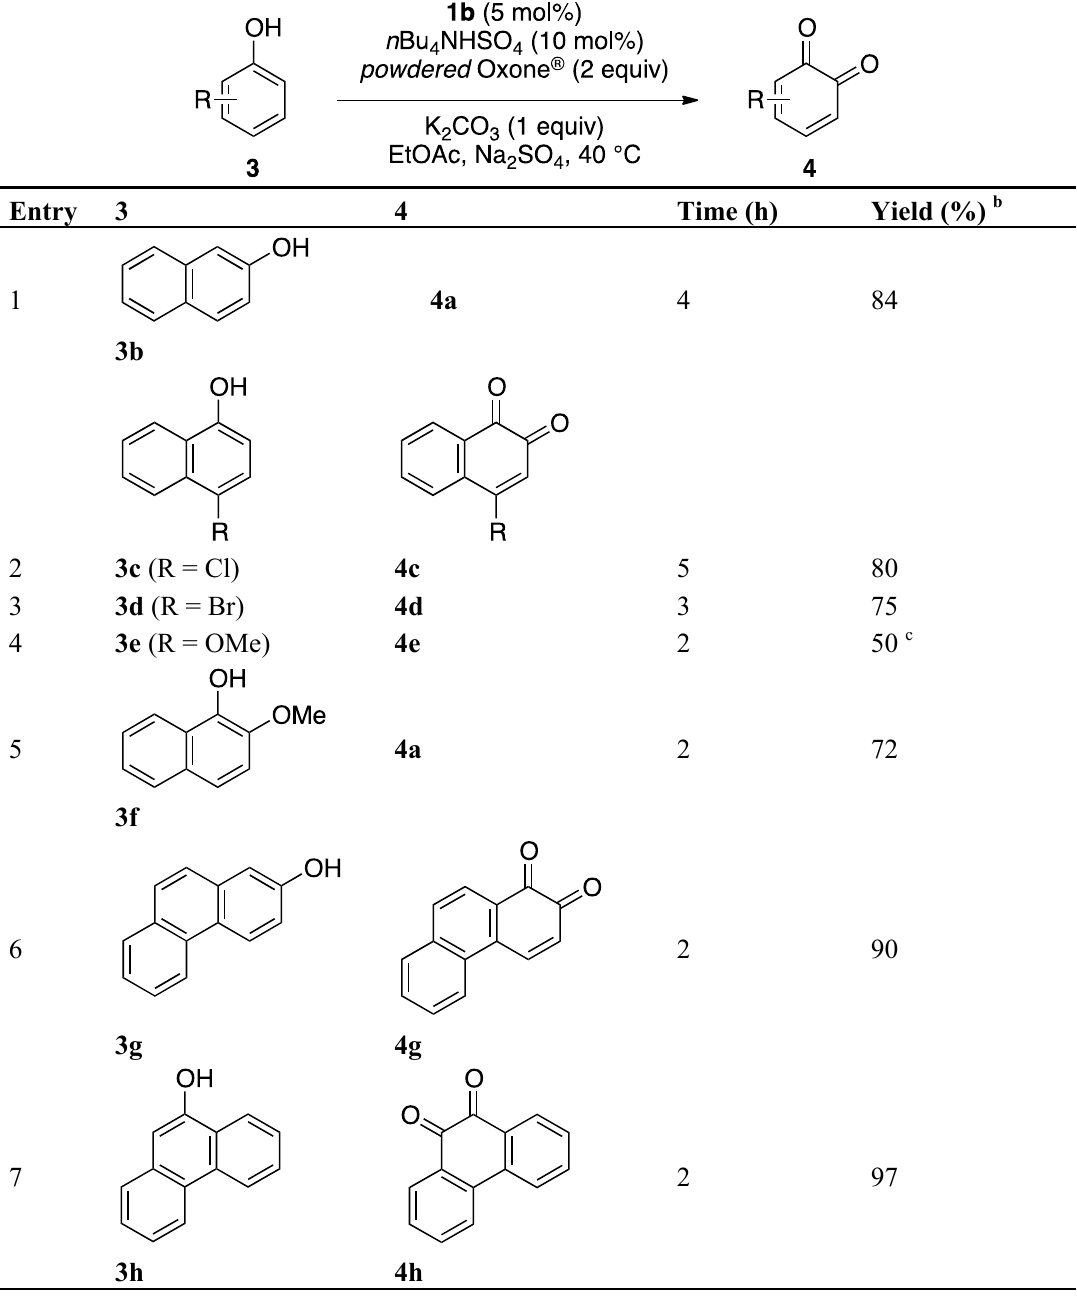
Table 2. 5-Me-IBS-catalyzed oxidation of naphthols, phenanthrols and phenols 3 a